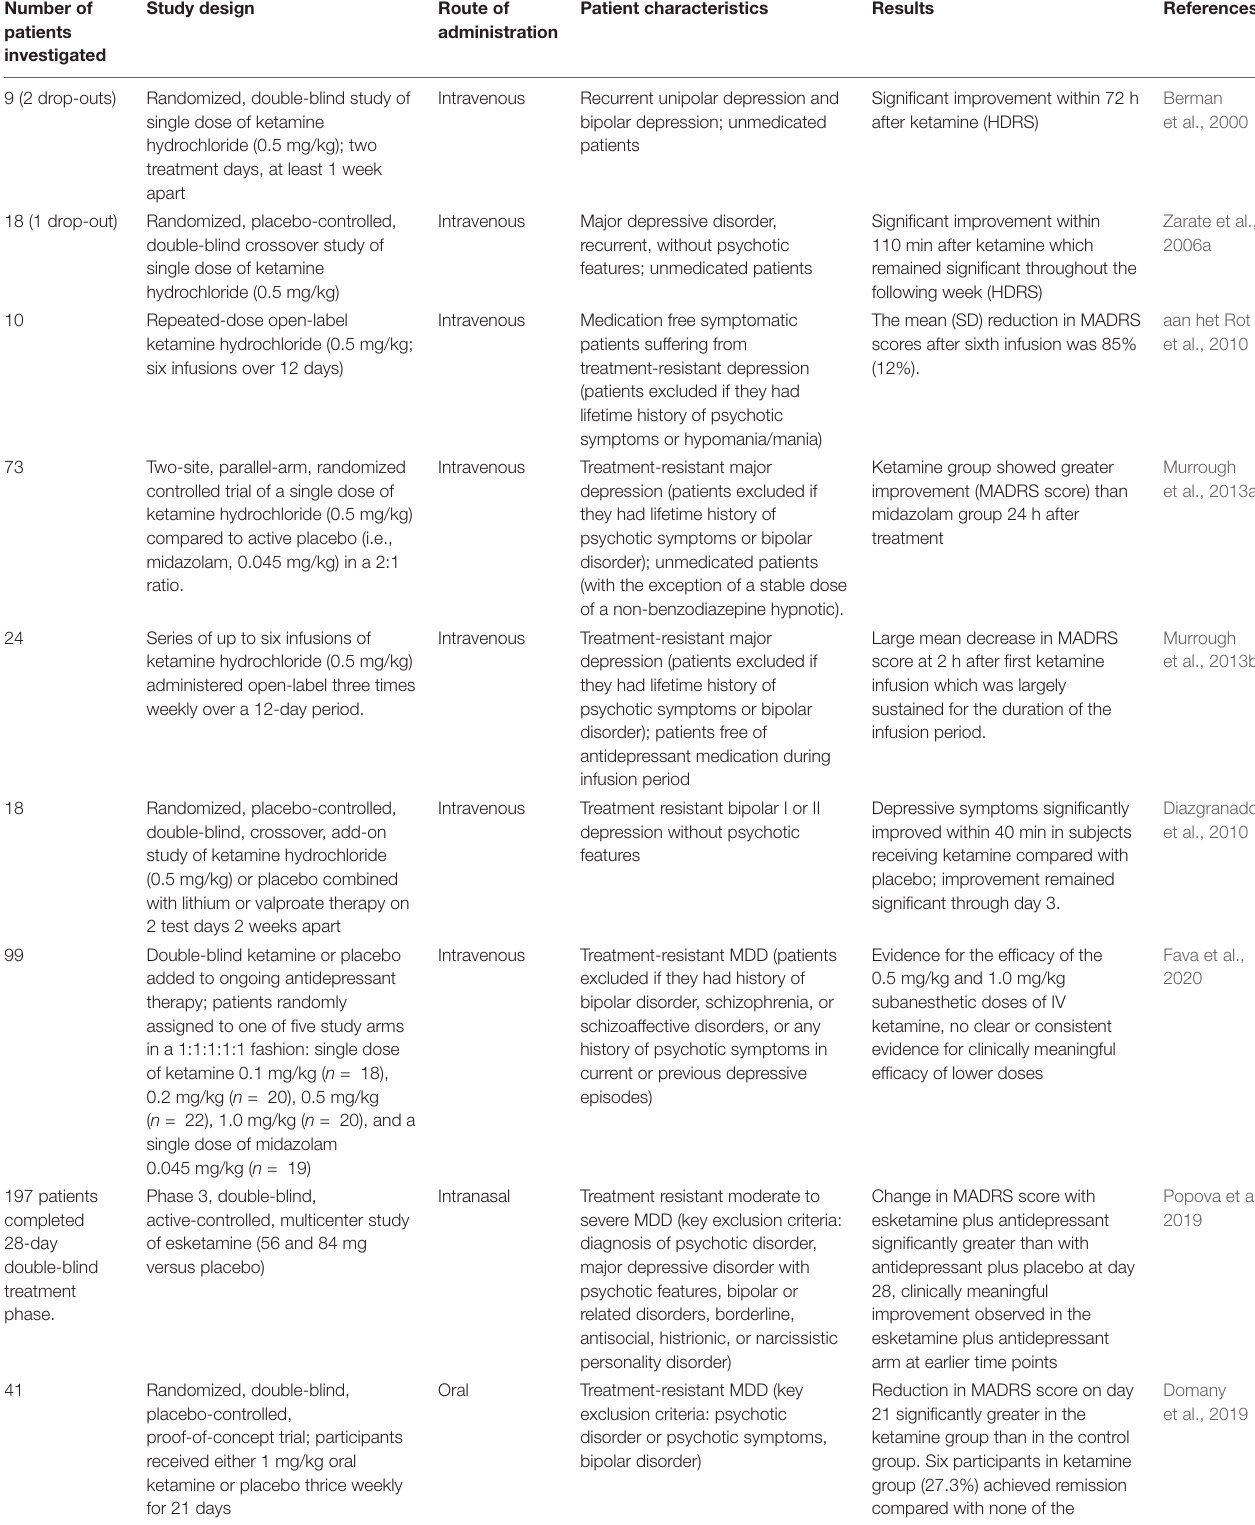
TABLE 1 | Overview of key studies of ketamine in